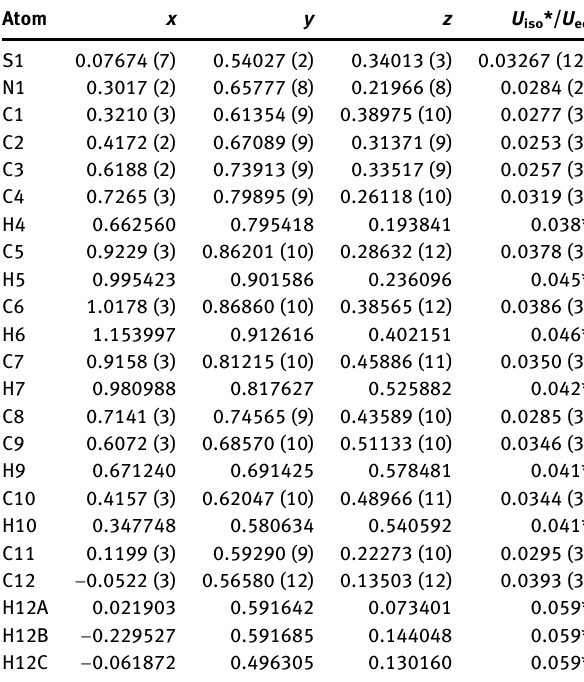
Table  : Fractional atomic coordinates and isotropic or equivalent isotropic displacement parameters (Å 